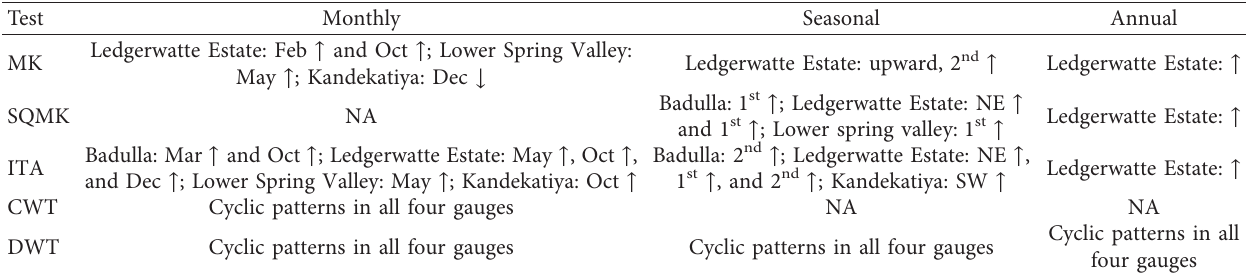
Table 3: Comparison of trend analysis.